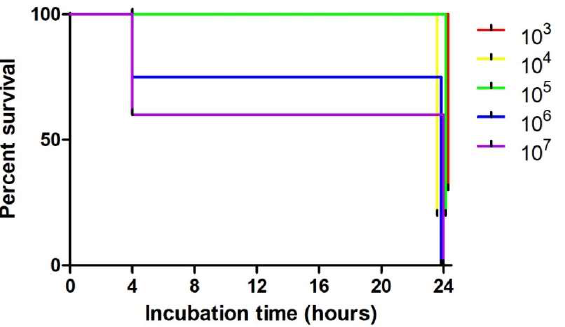
Figure 4. Kaplan-Meier survival curve of Omphisa fuscidentalis that was injected by E. fergusonii TB1 in 4 and 24 h after incubation. Dosage unit is in CFU/larvae.